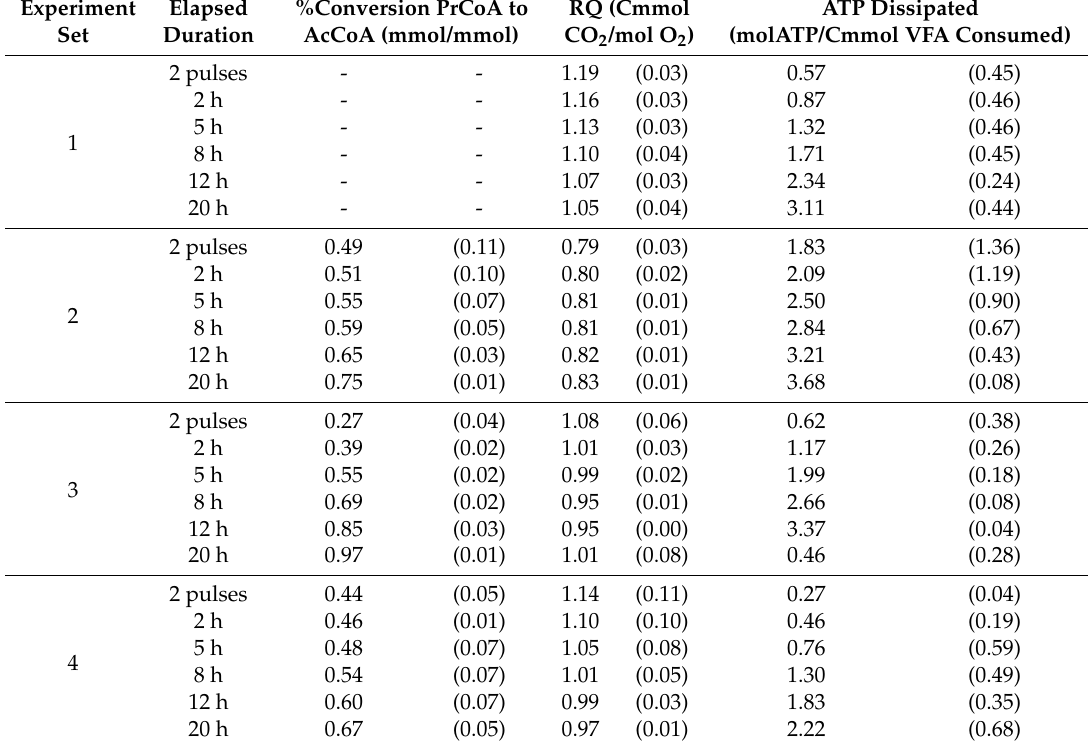
Table 3. Propionyl-CoA decarboxylation fraction, respiratory quotient and energy dissipated estimated by MFA (with standard deviation in